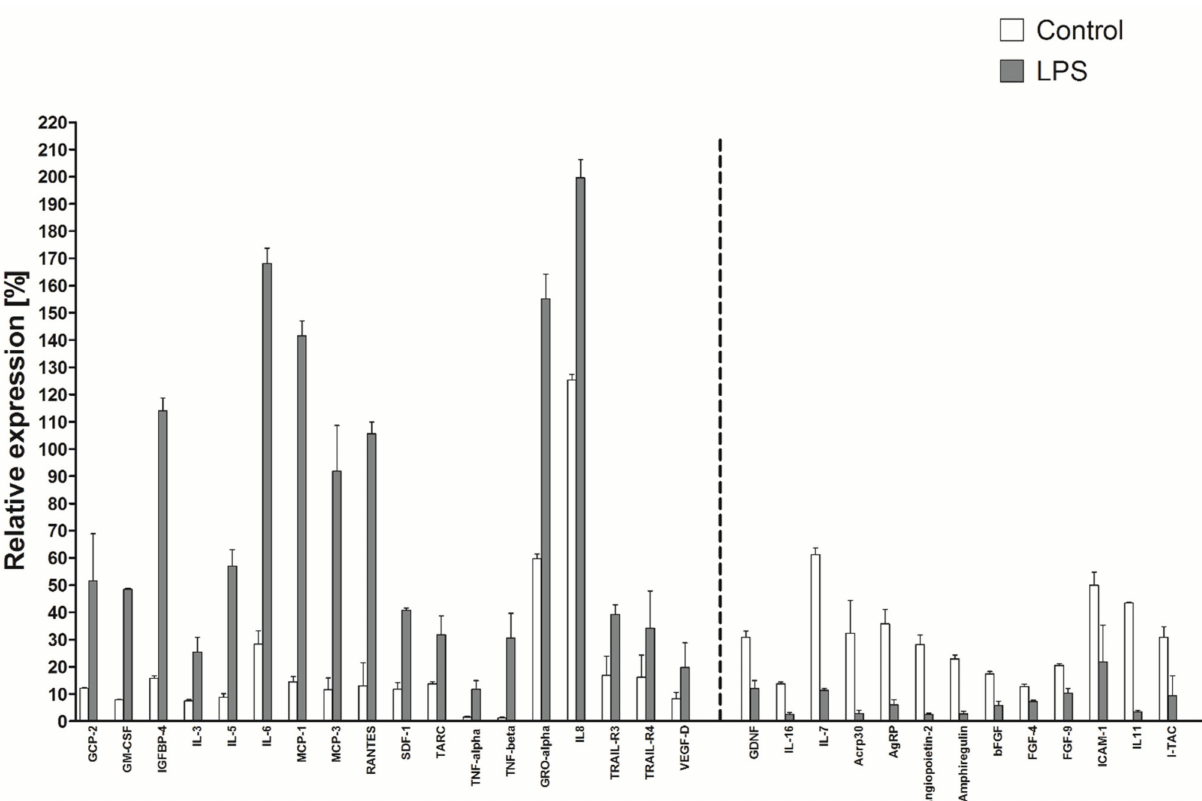
Figure 10. Selected cytokine production after a 24 h LPS stimulation of cell culture. The secretory profile of the tested line was determined using the RayBio C-series Human Cytokine Antibody Array for a panel of 120 cytokines and expressed as a histogram relative to a positive control. Cell cultures were established and stimulated with 100 µ g/mL of LPS to receive supernatants. The data represent the mean from a duplicate assessment ±